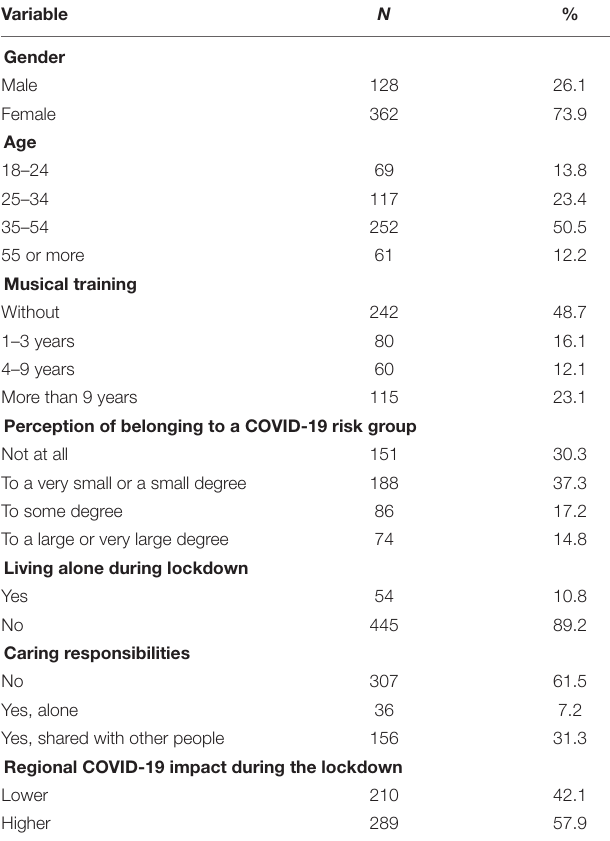
TABLE 1 | Descriptive characteristics of the